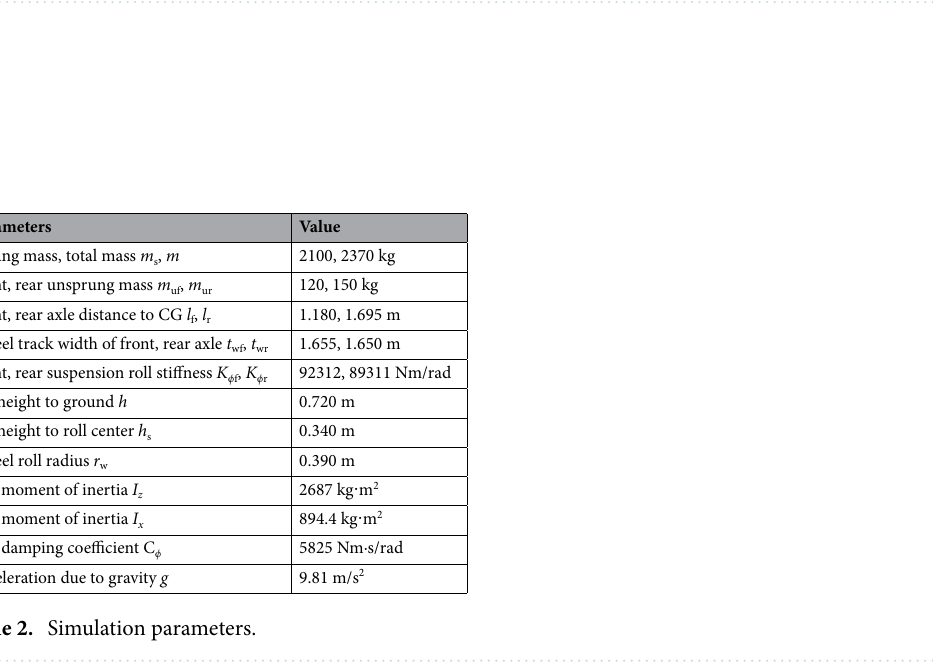
Figure 8. Flow chart of the integrated emergency collision avoidance decision-control.